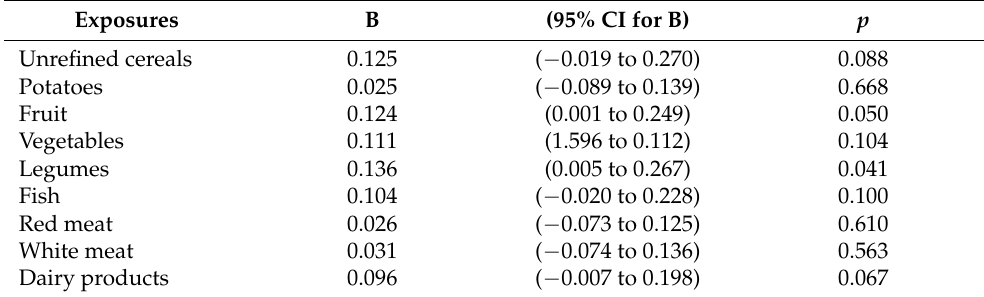
Table 3. Association between the consumption frequency of a specific food by the students and the consumption frequency of the same food by the parents at multivariate linear regressions